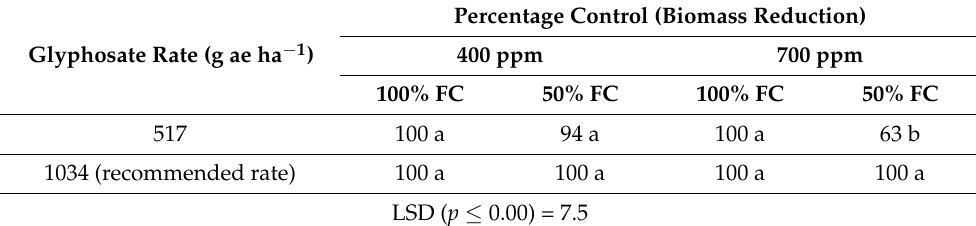
Means with different letters in each column differ significantly at p < 0.05. Abbreviations: FC, field capacity; LSD, least significant difference.